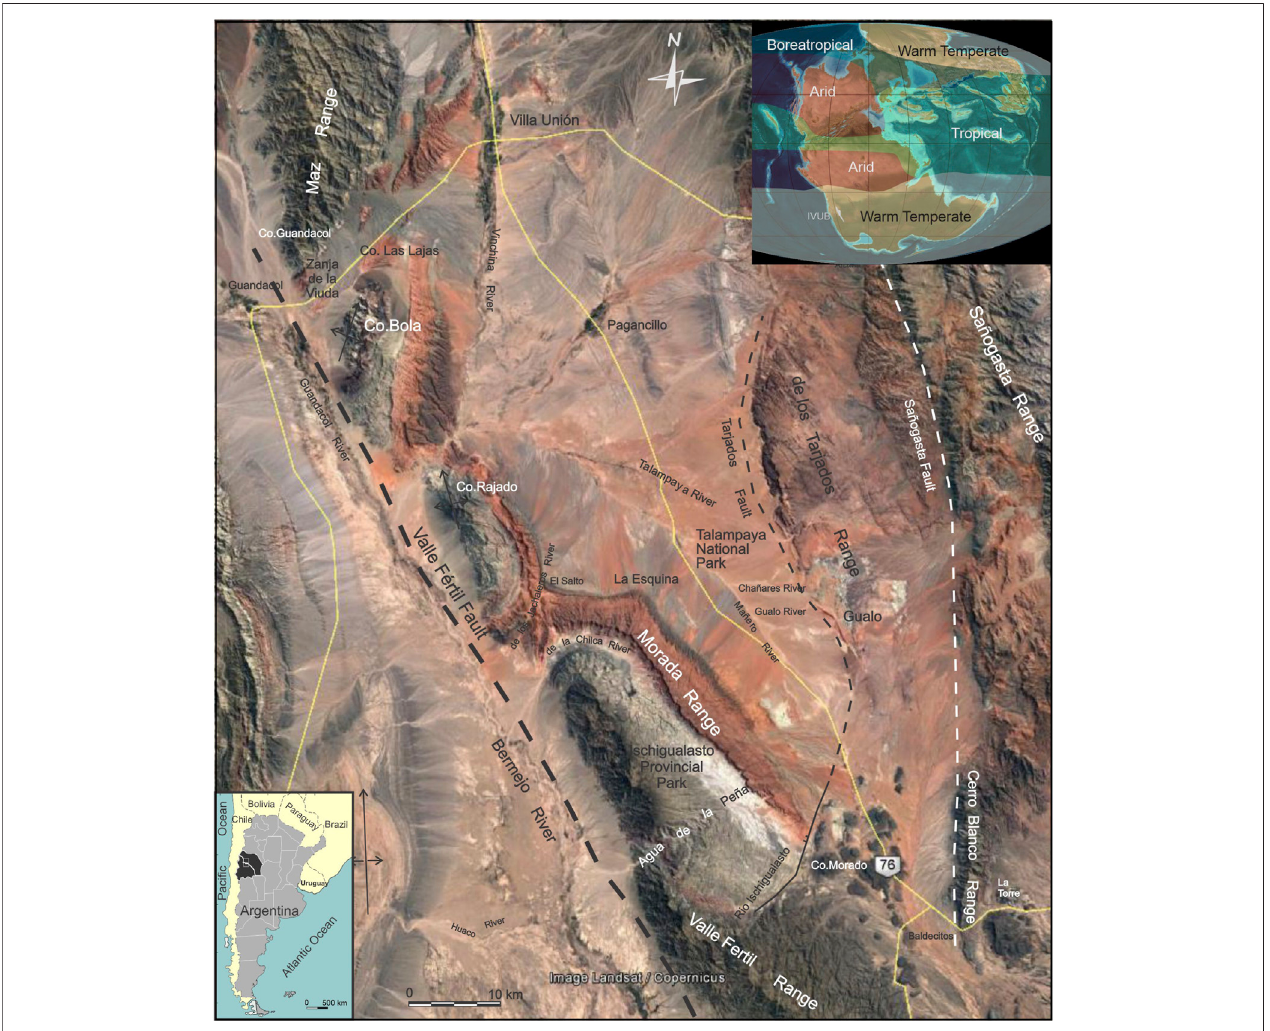
FIGURE 1 | Satellite image of the Ischigualasto-Villa Unión Basin with localities relevant to this study labeled. The satellite image is taken from Google Earth. PaleogeographicmapfortheLateTriassicPeriod(modi fi edfromhttps://deeptimemaps.com/)withpaleoclimateinferredzonesfromlithologicalindicators(modi fi edfrom Boucot et al.,